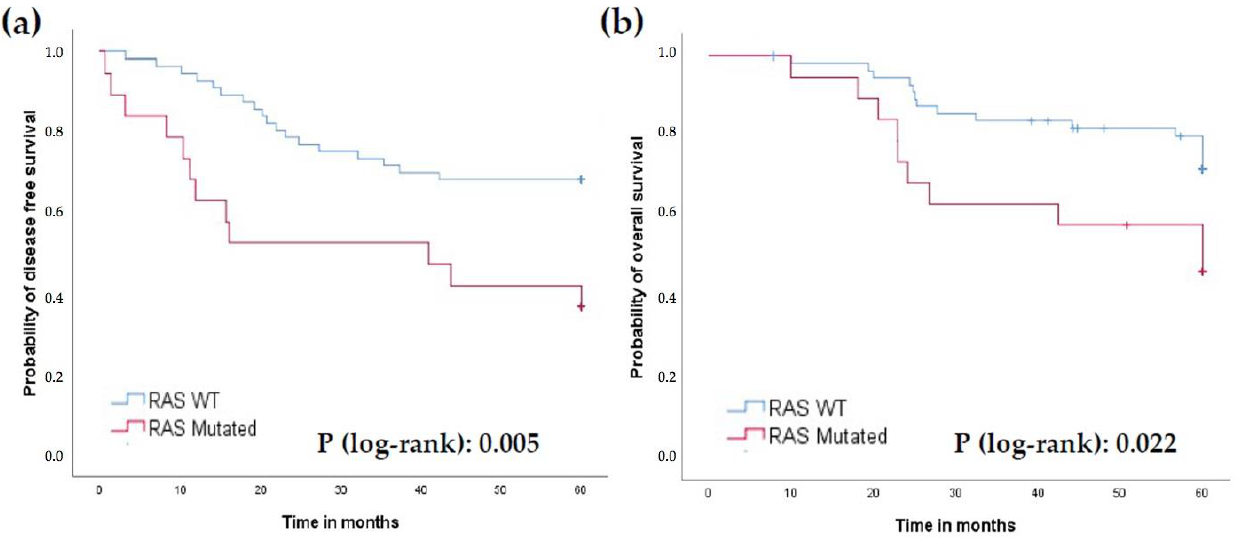
Figure 2. Prognostic role of KRAS status. ( a ) Progression-free survival (PFS). ( b ) Overall survival (OS).